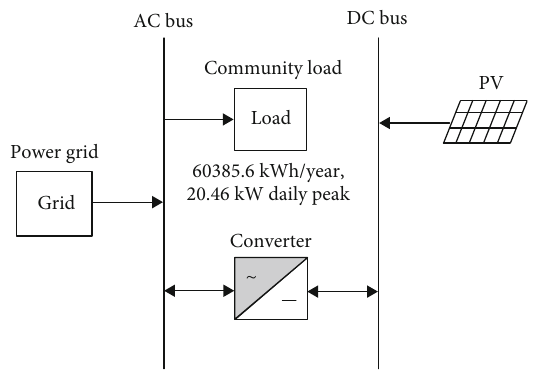
Figure 28: Schematic diagram of the hybrid grid-PV minigrid without